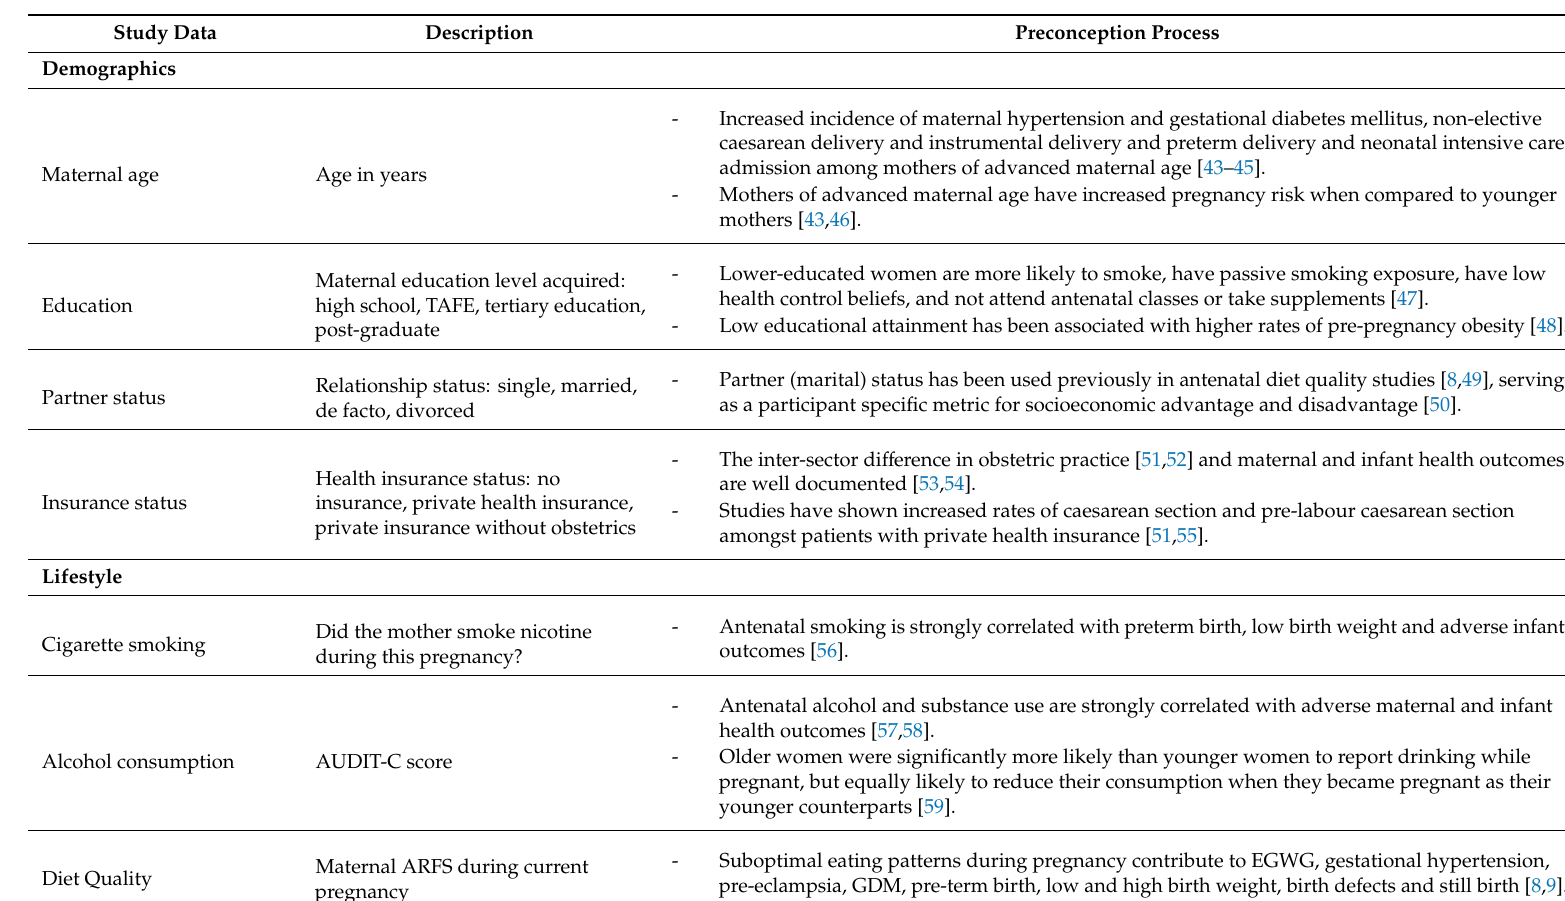
Table A1. List of characteristics collected via patient medical records and evidence of association on preconception process influencing health outcomes and healthcare-resource